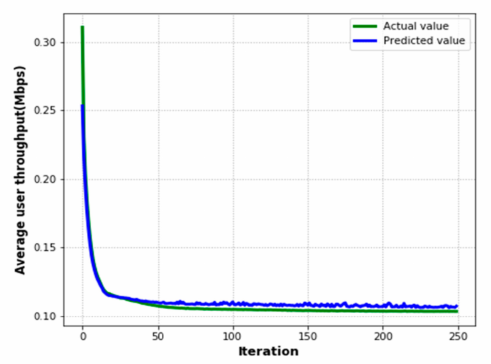
Figure 10. Actual and predicted value evaluation of throughput distributions.